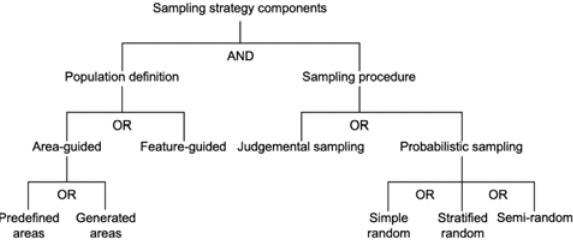
Figure 41: Choosing a sampling strategy for quality checking by logical feature or by areal selection (ISO/TC19157).